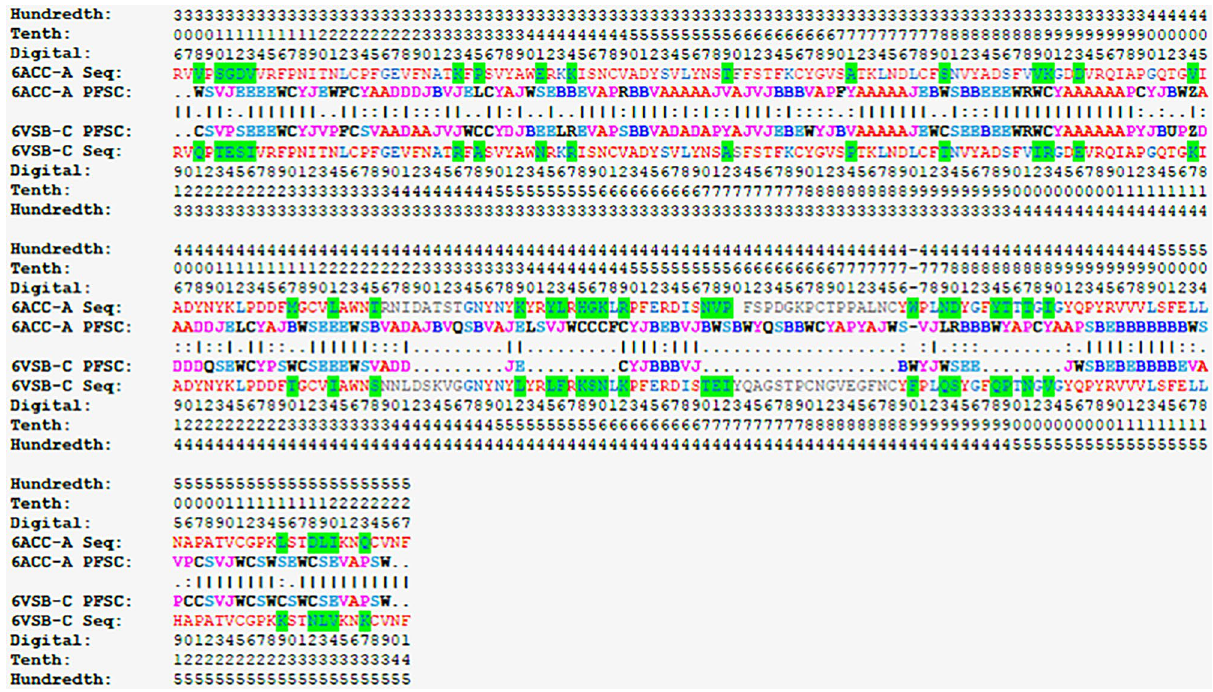
Table 3. PFSC string alignment between SARS-CoV (PDB 6ACC-A-306–527) and SARS-CoV-2 (PDB 6VSB- C-319–541). The rule of residue position and amino acid sequences are above or below the sequence separately. In the sequence, red font indicates highly conserved, blue indicates less conserved and gray indicates unaligned. The green background indicates the different residues between two sequences. Each PFSC letter represents the folding shape of 5 amino acid residues. For PFSC, generally the red color indicates a typical alpha helix, pink indicates an alpha-like helix, blue indicates a typical beta strand, light blue indicates a beta-like strand, and black indicates an irregular fold. In the alignment, the local folding similarity and differences between PFSC strings are indicated; “|” indicates an identical folding shape, “:” indicates a similar folding shape, and “.” indicates dissimilar